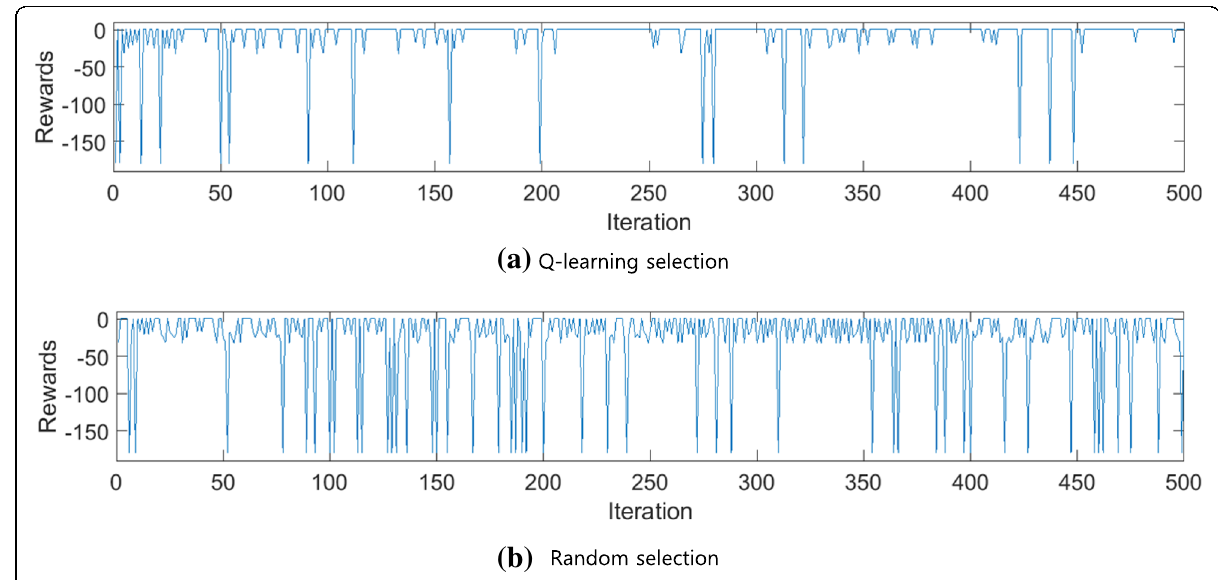
Fig. 24 Rewards for a Q-learning and b random channel selection according to iteration (DDR = 3.5 Mbps). Figures 22, 23, and 24 show the rewards for Q-learning and random band and channel selection according to the iteration for each DDR. In the case of Q-learning for all DDRs, the fluctuation decreases over time and the system operates with the intended reward design. In the random selection, there are more notches and fluctuation than Q-learning selection